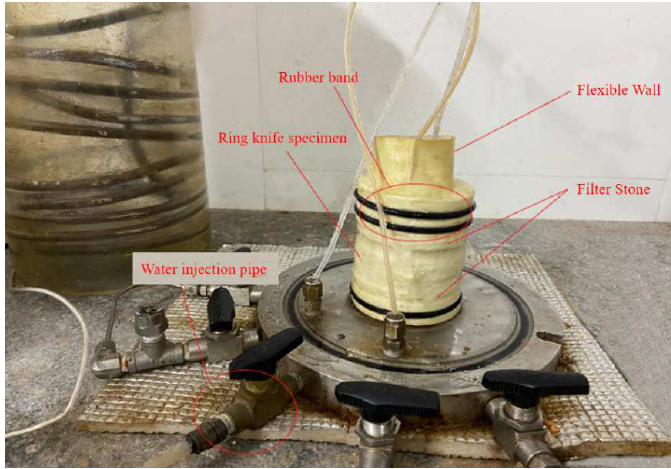
Figure 2. Physical picture of transparent clay permeability test sample assembly.